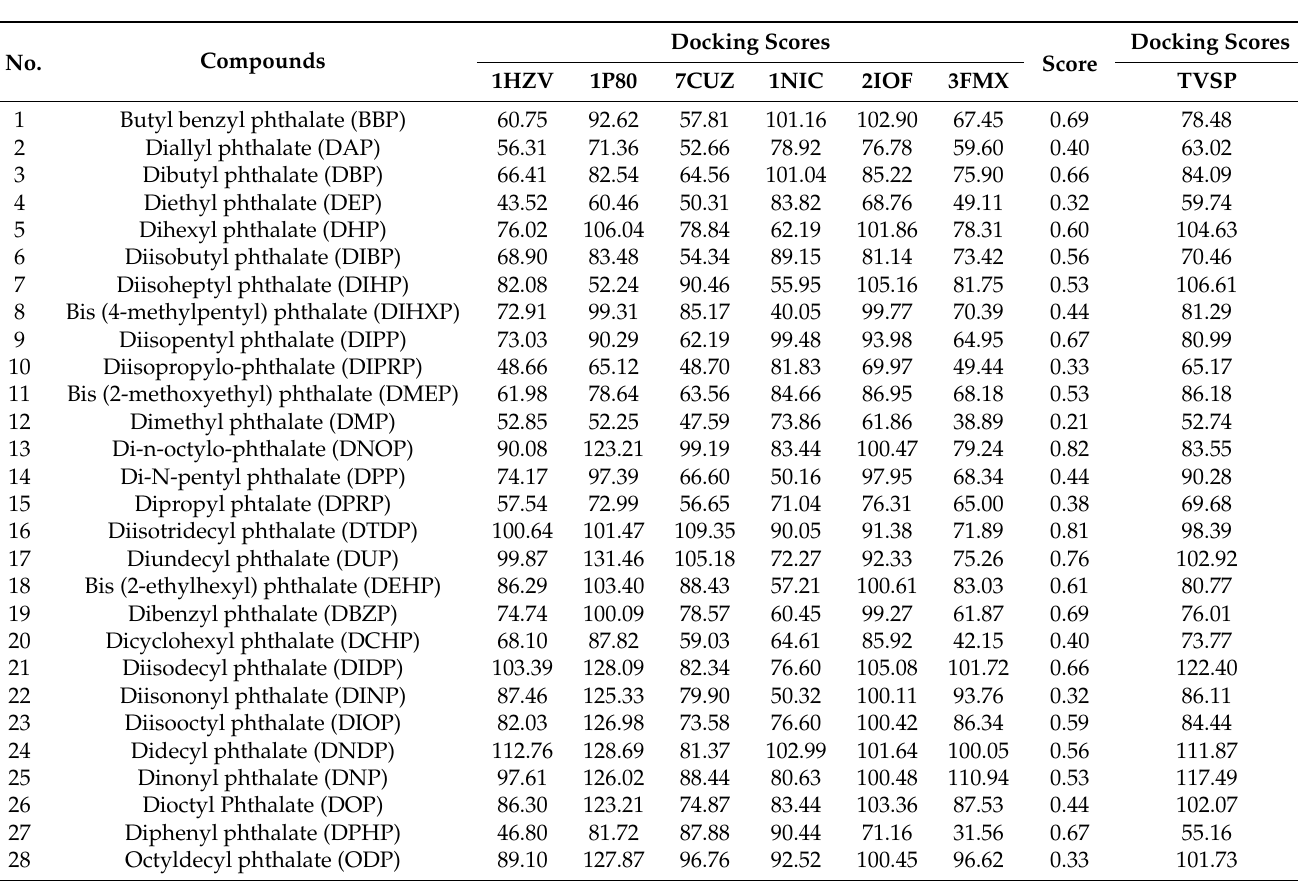
Table 1. Comprehensive effect value of PAEs and microbial degradability associated with the water treatment process, and the scoring function value of PAEs and the soil microbial complex degrading